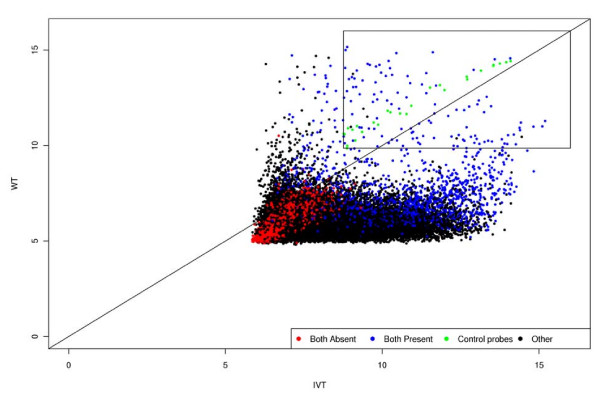
Comparison of the 3'IVT (sense signal) and WT (antisense signal) array distributions. The summarized log2 expression value for all probe sets (n = 61,127). Red spots indicate probe sets with absent MAS 5.0 PMA calls (P < 0.01) in both assays, black spots indicate probe sets called as present in one assay only, blue spots indicate probe sets with present calls in both assays, and green spots indicate the replicated spiked-in hybridization controls (bioB, bioC, bioD and creX). The black box shows the probe sets with expression values greater than the spiked-in hybridization controls in both assays, which were considered as positively hybridizing for this study.